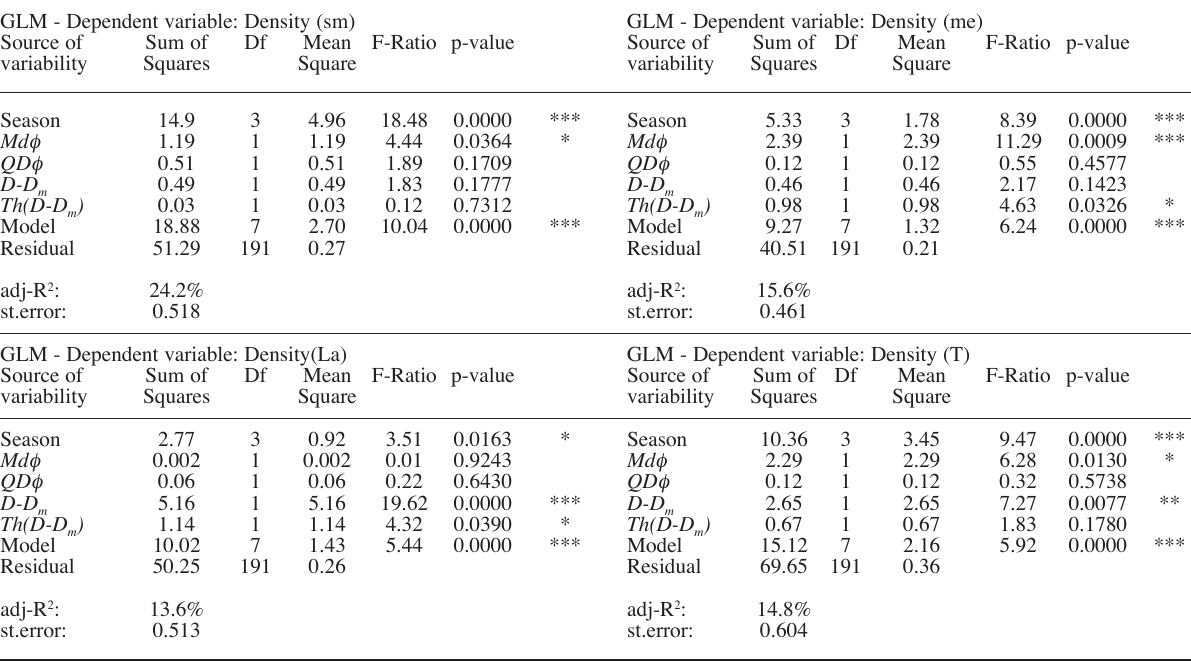
T ABLE 1. – Summary of the results of fitting 4 general linear statistical models relating the octopus densities of each size class (sm-small, me- medium, La-large) and the total densities (T) to 5 predictive environmental factors (* p<0.05, ** p<0.01, ***